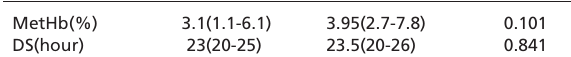
Table 8 - Discharge time (DS) and methomoglobin values at 60 minutes (metHb) (median value, minimum- maximum).